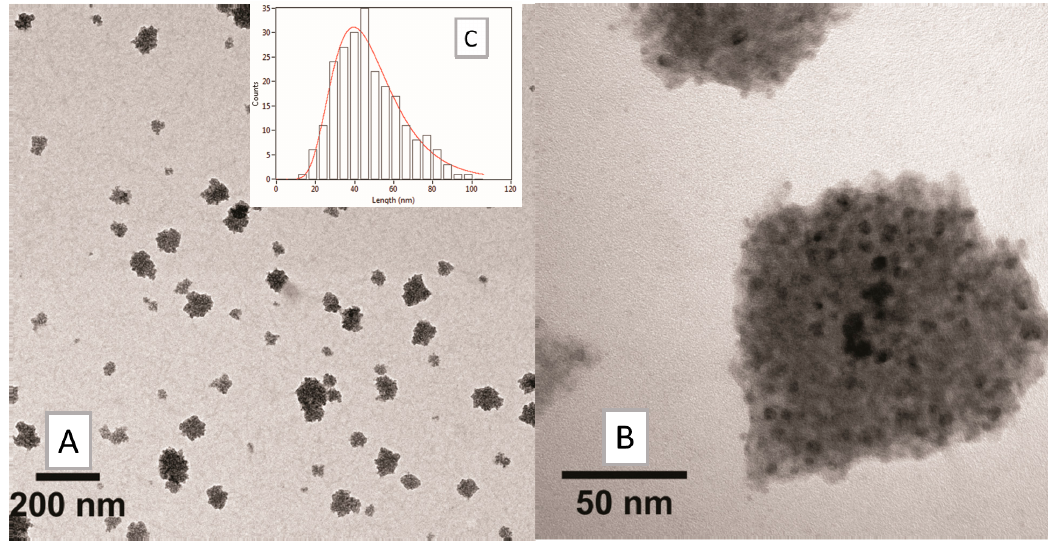
Figure 10. TEM analysis on SPION3: ( A ) low and ( B ) high-magnification bright field micrographs, and ( C ) size distribution histogram of the nanosystems. Table 3. Different HA amounts (mg) used for the preparation of Fe 3 O 4 · DA-BSA/HA